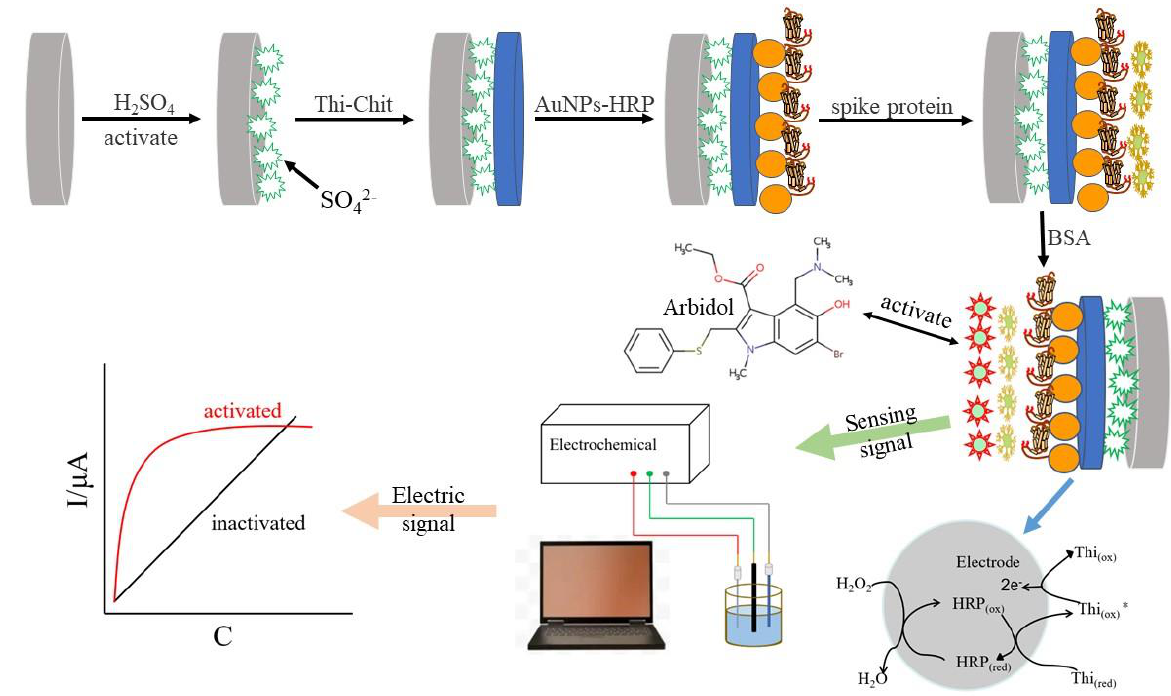
Figure 1. Schematic illustration of the fabrication process of the spike protein receptor biosensor.